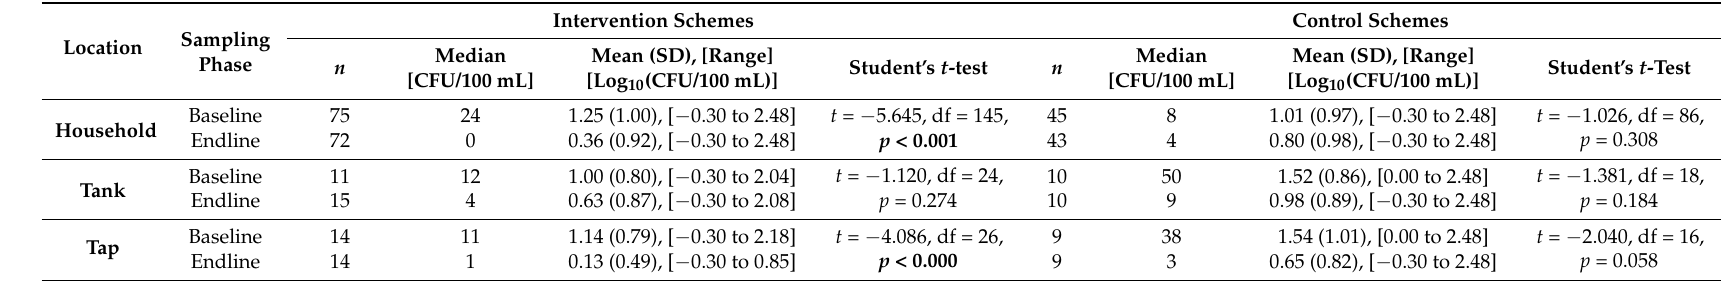
Table 5. Escherichia coli concentrations at each sample location for the intervention and control schemes, with bivariate comparisons of the mean E. coli contamination at the baseline and endline